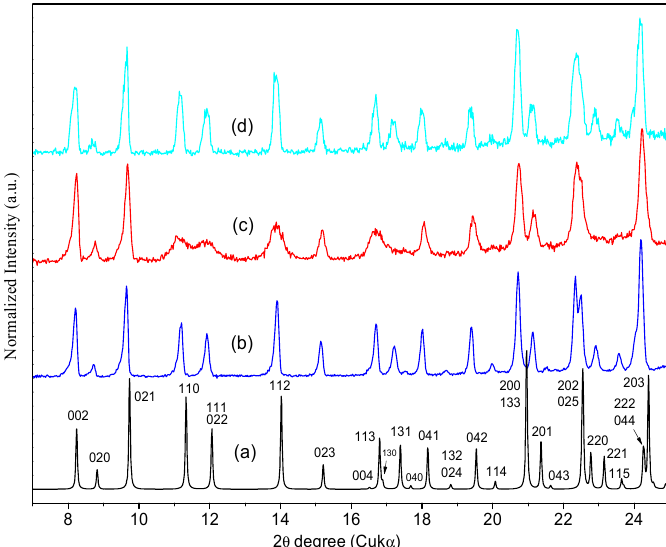
Figure 9. PXRD patterns of ORBI: (a) Calculated from the ORBI hemihydrate form (the Miller indices identifying the Bragg peaks are included); (b) experimental PXRD patterns of Sigma ORBI Standard as received (ORBI hemihydrate form); (c) experimental Sigma ORBI Standard after heating at 200 °C for 10 h (ORBI anhydrous form); (d) Sigma ORBI Standard after heating at 200 °C for 10 h followed by treatment in a climatic chamber at 40 °C with 75% relative humidity during 1 h (rehydrated form = ORBI hemihydrate form). All thermal treatments were ex-situ .